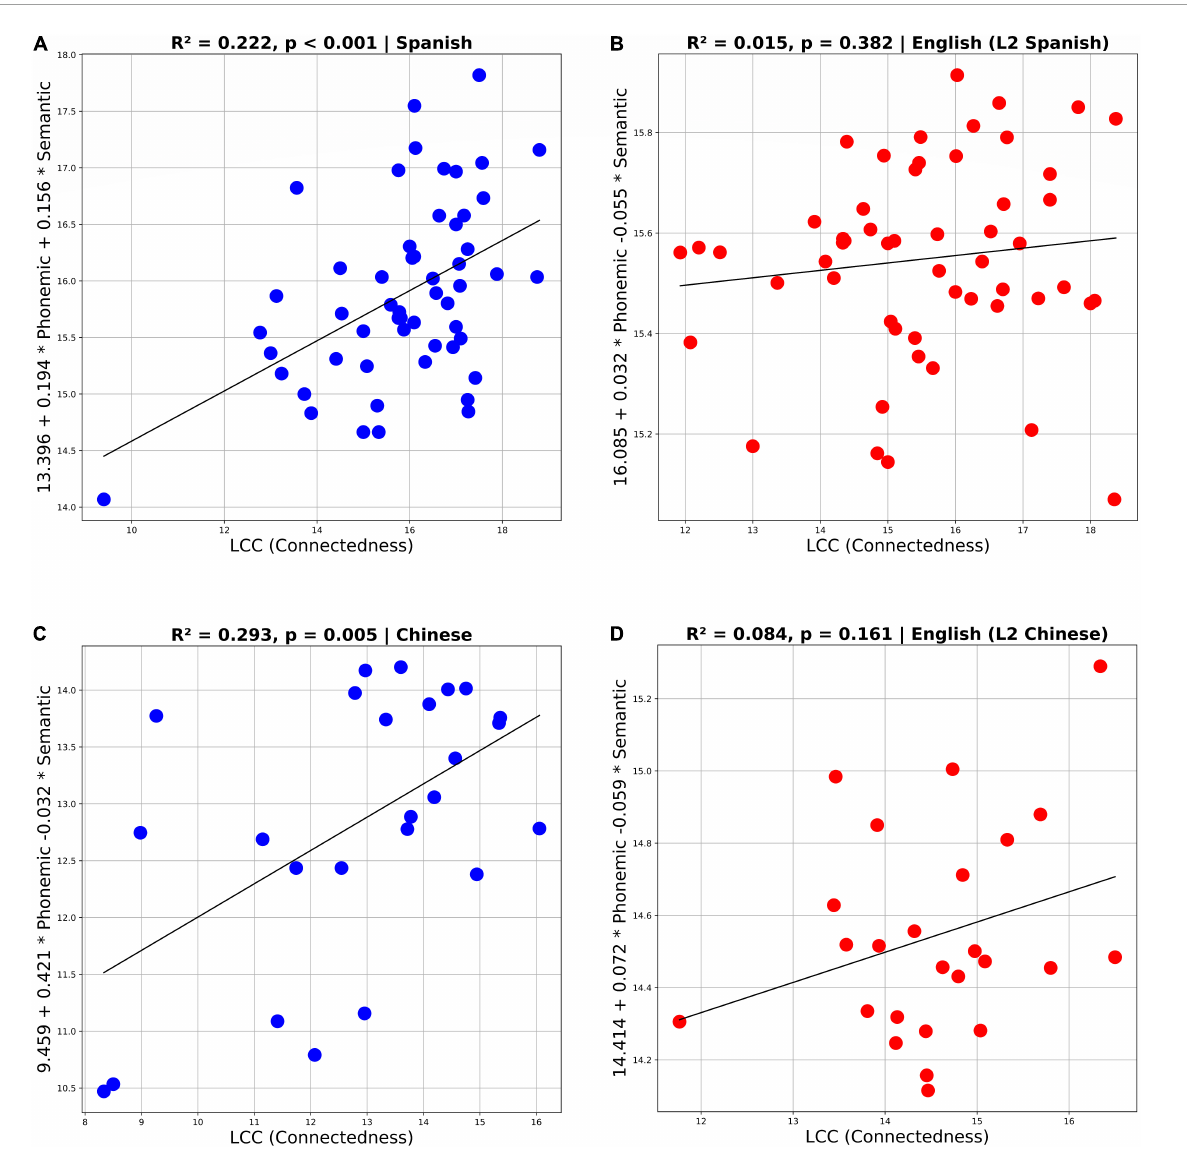
FIGURE2 Multiple regression scatterplots showing the contribution of phonemic and semantic fluency to explain connectedness (LCC) in L2 Spanish and Chinese (A,C) and in L1 English (B,D) .